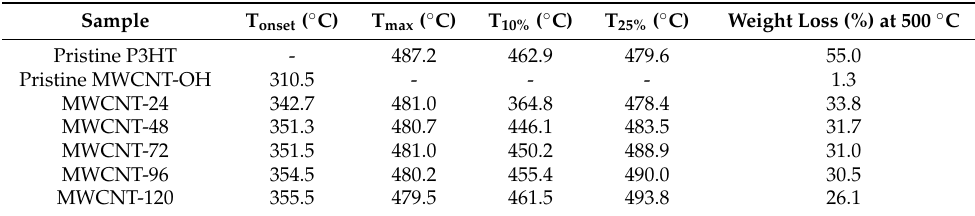
Table 4. Characteristic temperatures of nanocomposites at elevated weight